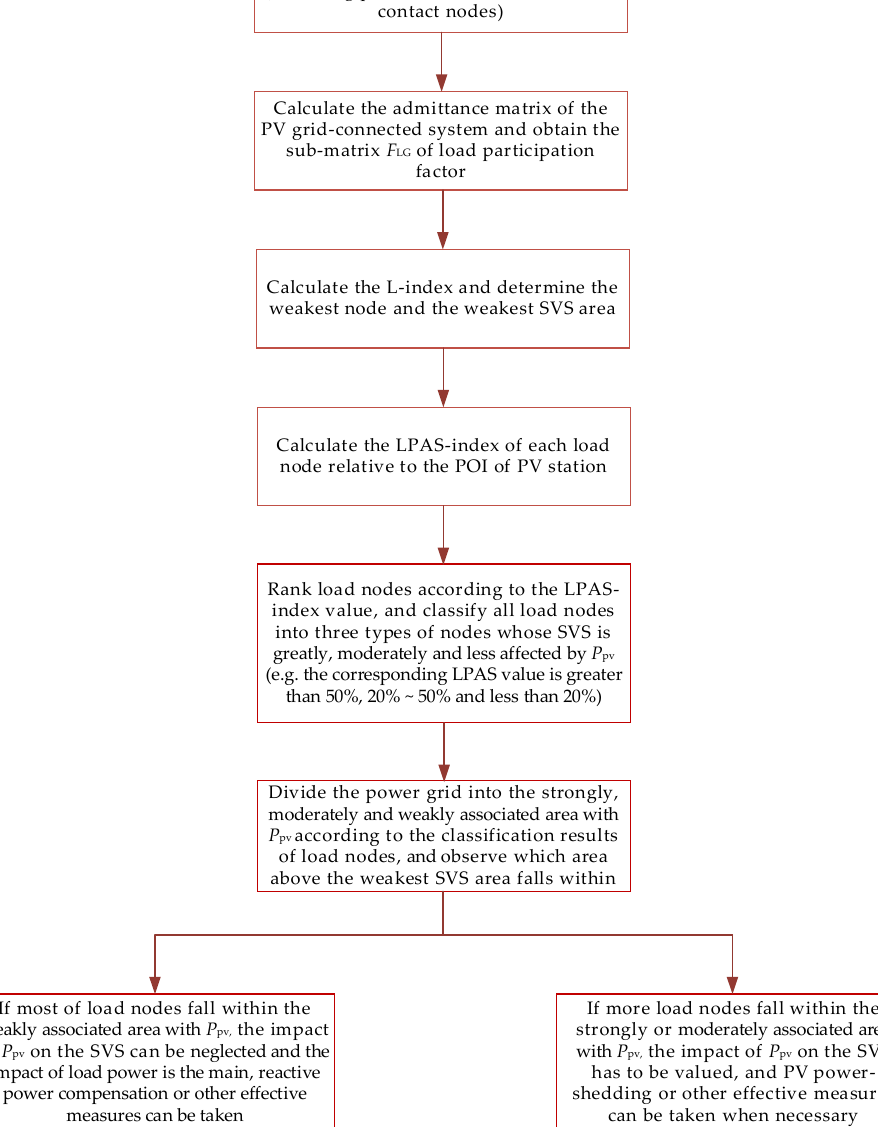
Figure 2. Flow chart of the SVS zoning analysis method.